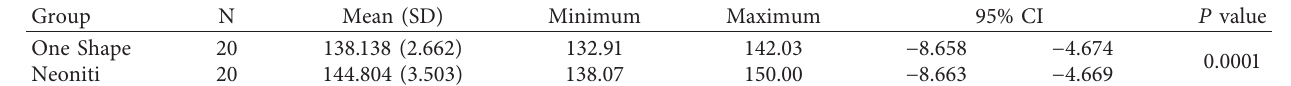
Table 3: Preparation time (in seconds) for rotary